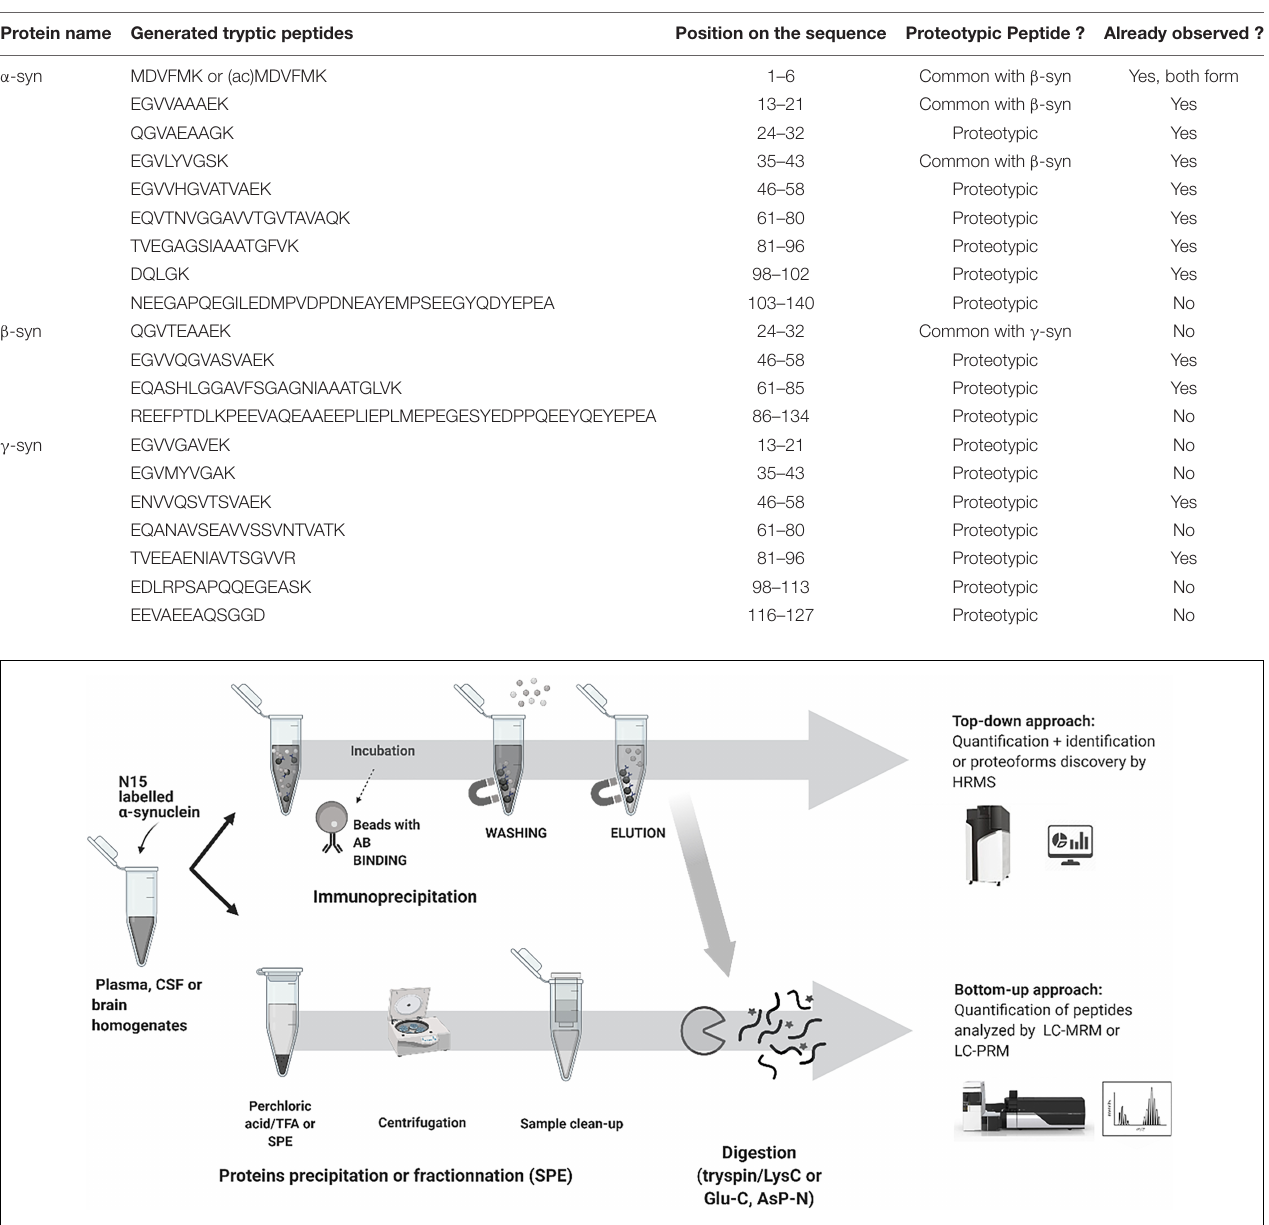
TABLE 3 | Synuclein generated tryptic peptides (observed or not in literature). Protein name Generated tryptic peptides Position on the sequence Proteotypic Peptide ? Already observed ?